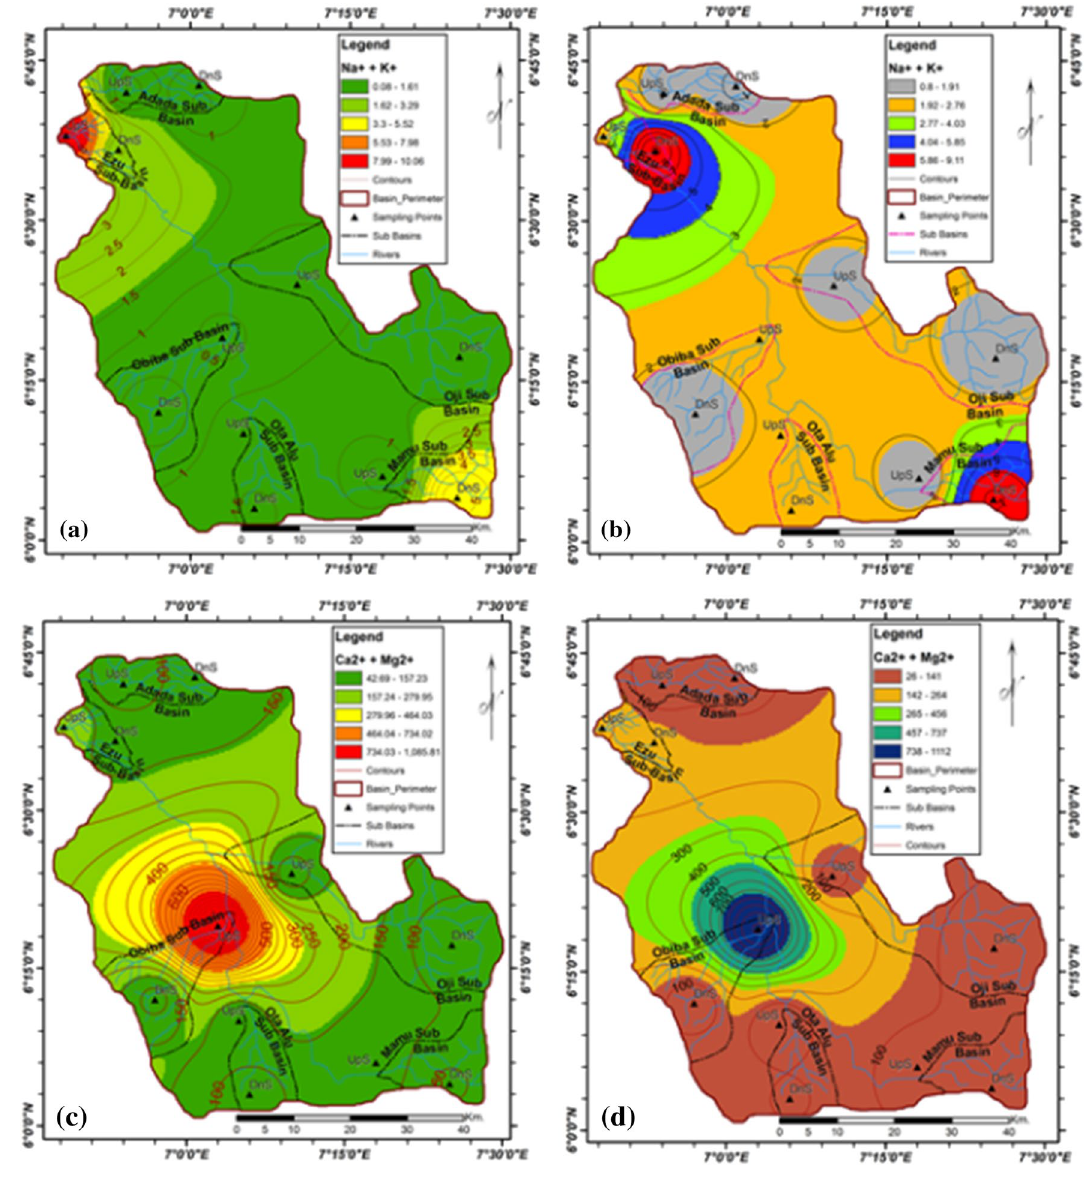
Fig. 13 Spatial distribution of Na + K and Ca + Mg in the basin